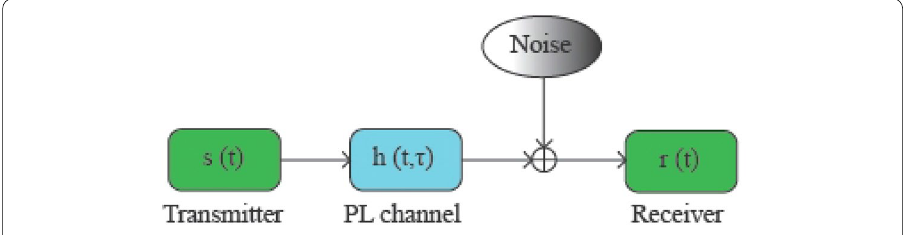
Fig. 2 PL Communication